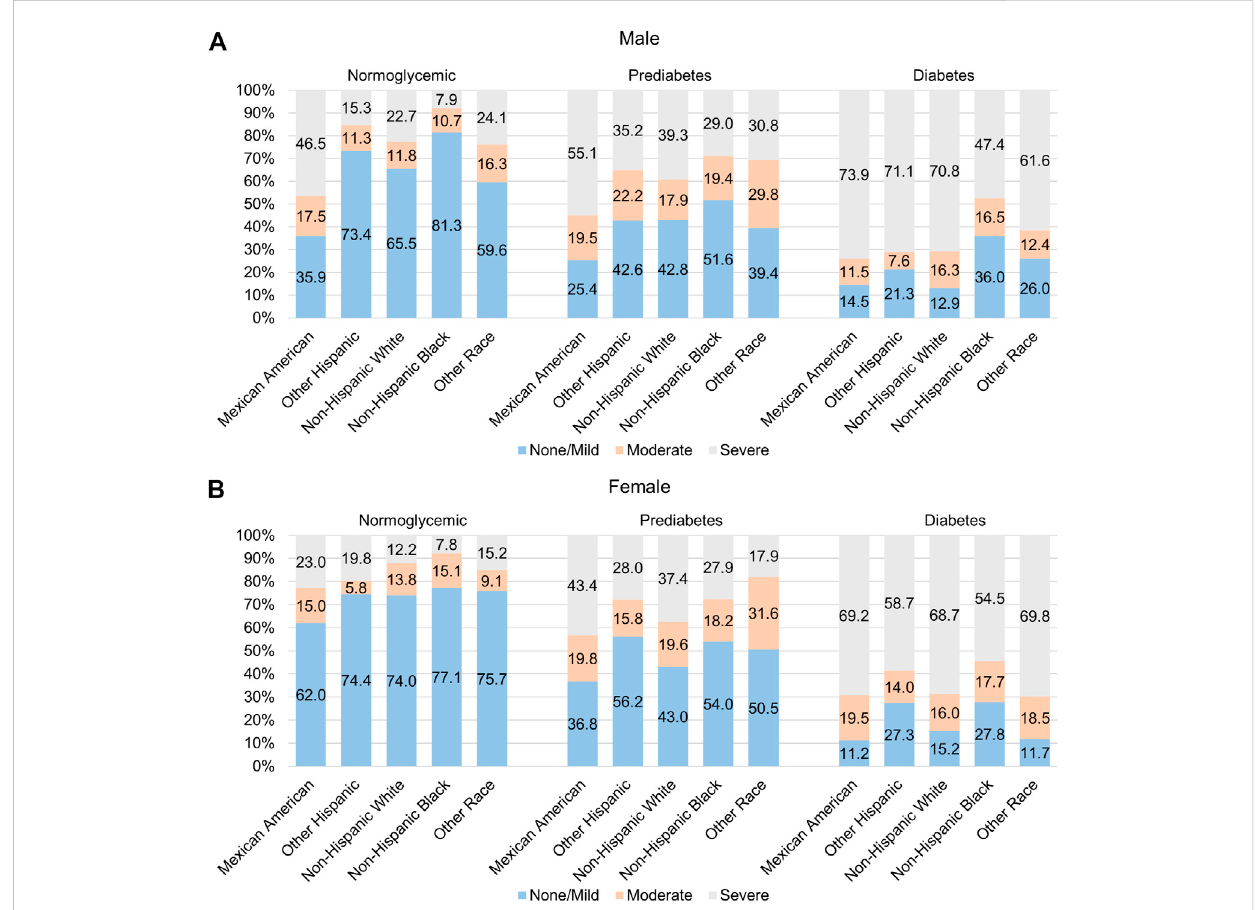
FIGURE 1 Racial/ethnic variation in prevalence of NAFLD among those with diabetes and pre-diabetes. Prevalence of moderate and severe NAFLD among (A) males and (B) females of different racial/ethnic groups who are normoglycemic (left) or have pre-diabetes (middle) or diabetes